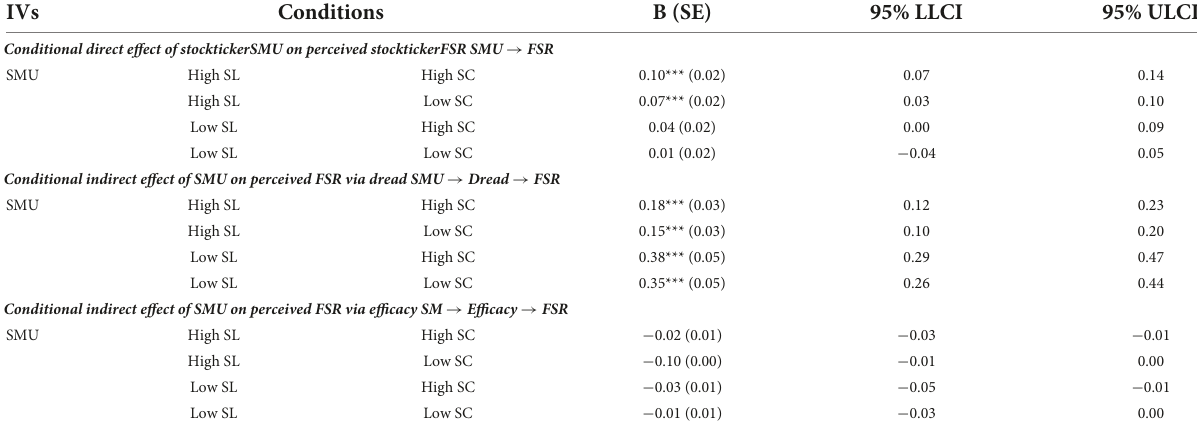
TABLE 5 Conditional effects analysis of the moderated mediation model.